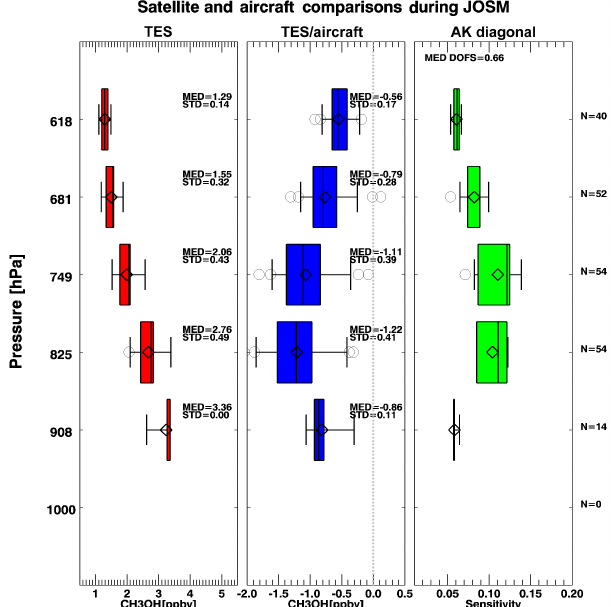
Figure 4. Summary box-and-whisker plots of the satellite/aircraft comparisons during JOSM for CH 3 OH binned at the various re- trieval altitudes. Only the TES pixels from 9 to 14 (counting from south to north) near the middle of the TES transect were included (based on trajectory results). The box edges are the 25th and 75th percentile, the line in the box is the median, the diamond is the mean, the whiskers are the 10th and 90th percentiles, and the circles are the outlier values outside the whiskers. The left panel contains a summary of the retrieved TES profile values, the middle panel contains the TES/aircraft profile differences (with the satellite ob- servation operator applied), and the right panel is the diagonal of the averaging kernel as an indication of the TES’s vertical